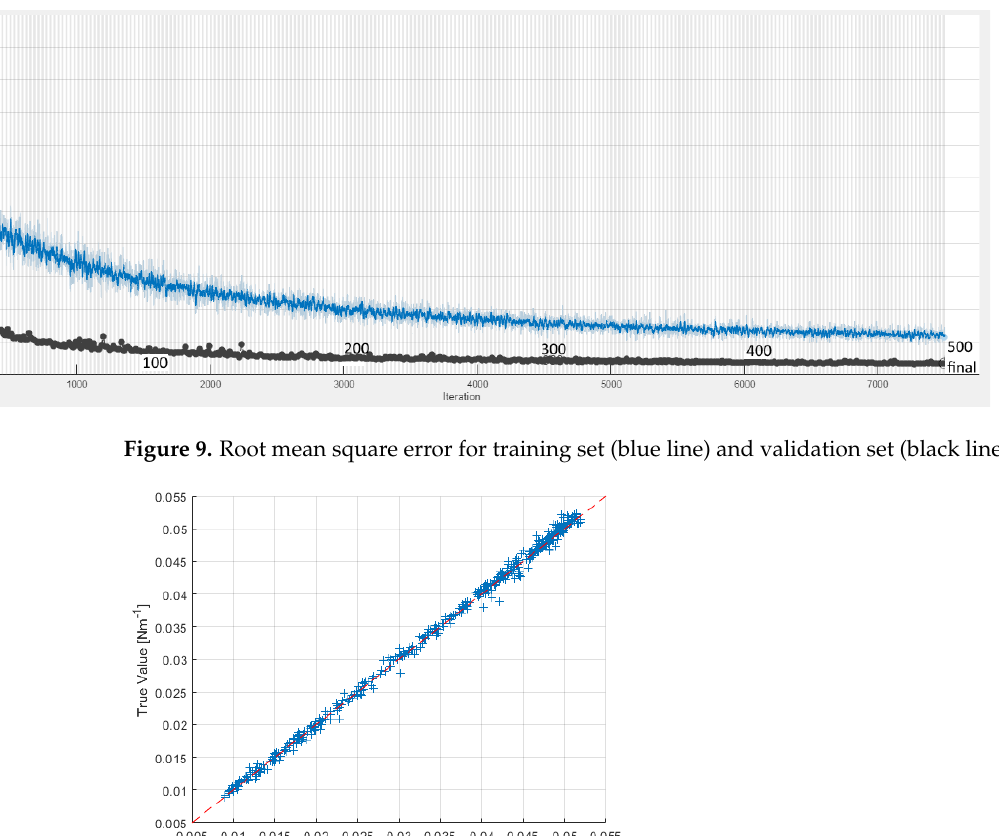
Figure 10. True values versus predicted values of the radial force value.